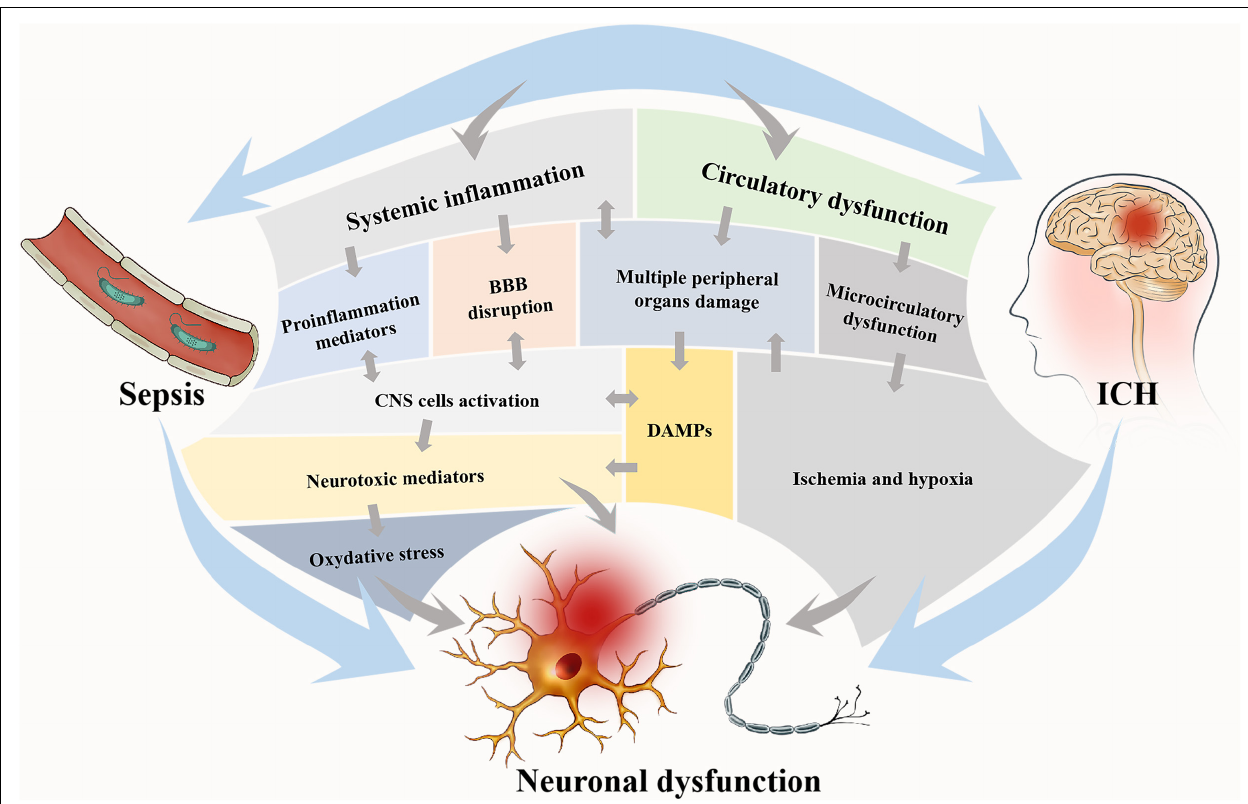
FIGURE 1 | Two main pathophysiological processes are involved in brain dysfunction in ICH with sepsis. These two processes are interdependent, on one hand, and mutually independent, on the other hand. Circulatory dysfunction will be followed by microcirculatory dysfunction and finally result in ischemia and hypoxia of tissues and multiple peripheral organ damages. In systemic inflammation, proinflammatory mediators will be released, and the DAMPs from the periphery will be allowed into the brain due to BBB disruption, which consequently activates CNS cells. The main consequence of these two processes is neural dysfunction, notably via oxidative stress and neurotoxic mediation. Neural dysfunction widely exists in the brain and accounts for the brain dysfunction via the alteration of neurotransmission. DAMPs, damage-associated molecular patterns; BBB, blood-brain barrier; CNS, central nervous system.